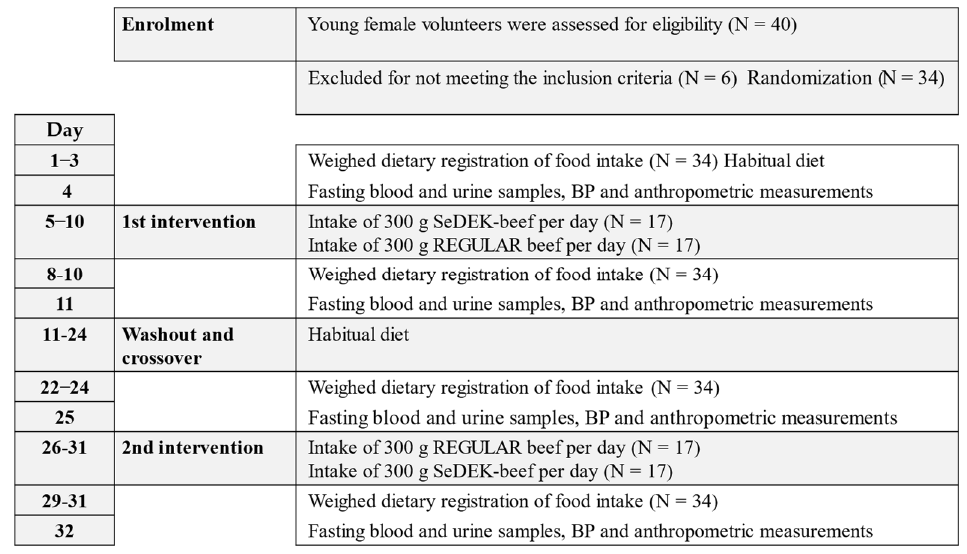
Figure 1. Timeline for the experimental design of the cross-over double-blind study. At baseline, energy content and nutrient composition of the normal, habitual diet were determined by weighted dietary registration (prospective registration) for three days using the “Kostholdsplanleggeren” [40].